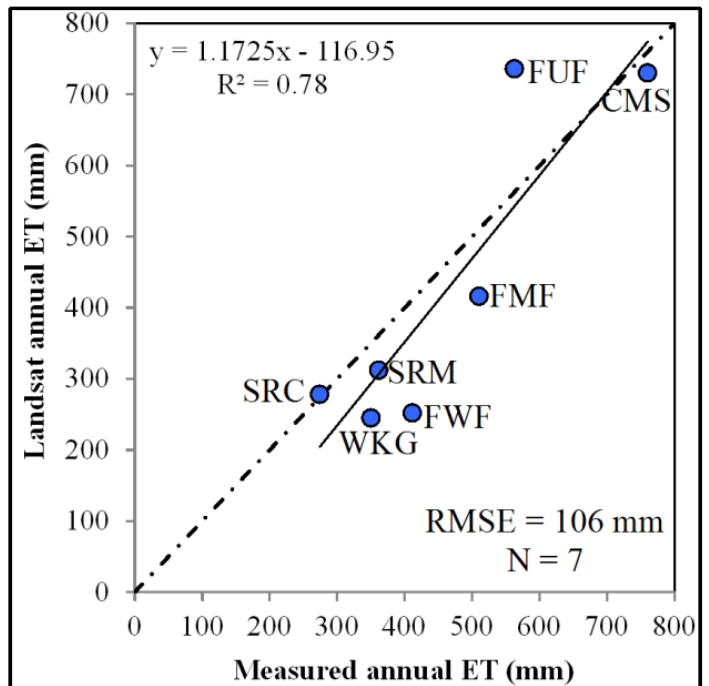
Figure 6. Validation of Landsat-based annual evapotranspiration with eddy covariance measured evapotranspiration at Flagstaff managed forest (FMF), Flagstaff unmanaged forest (FUF), Flagstaff wildfire (FWF), Santa Rita Creosote (SRC), Santa Rita Mesquite (SRM), Kendall Grassland (WKG), and Charleston Mesquite (CMS) sites. Removal of FUF and FWF sites resulted in y = 0.997x − 53.767 (R 2 = 0.95) and RMSE of 68